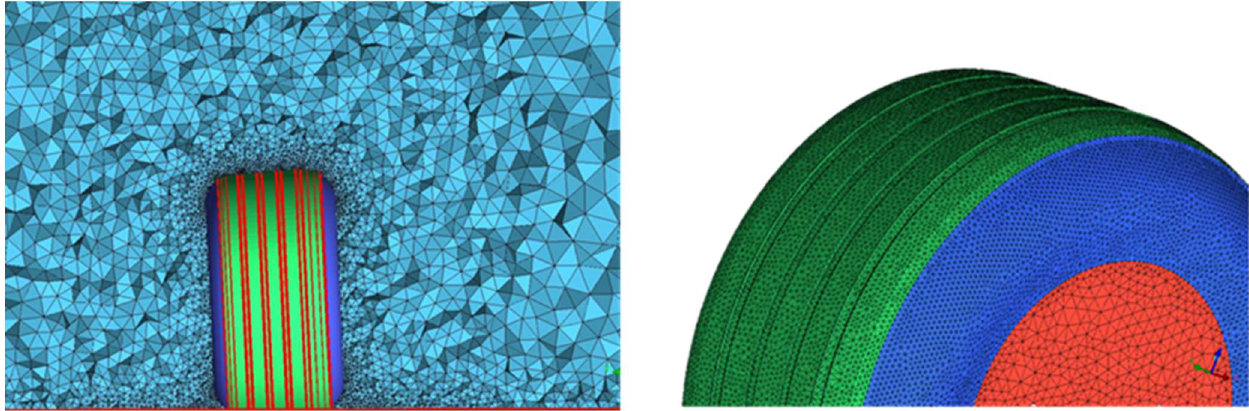
Figure 2. Volume mesh cut plane ( left ) and surface mesh detail of the wheel ( right ).